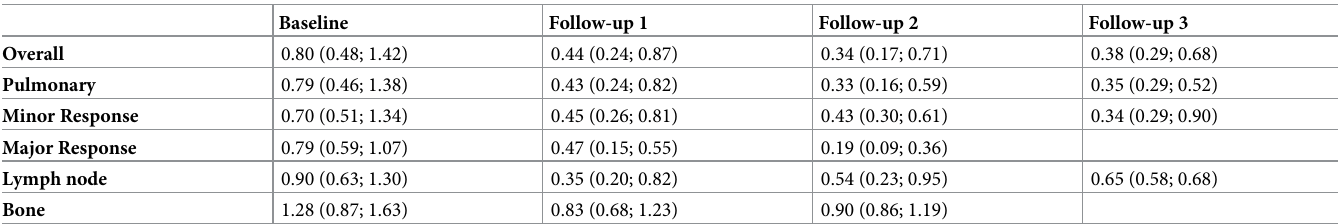
Table 2. K trans